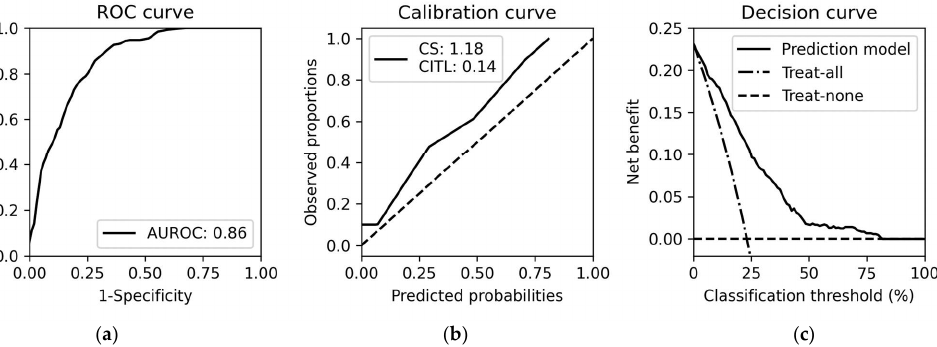
Figure 2. ARC predictor performance represented by ( a ) ROC curve; ( b ) calibration curve ( c ) decision curve. AUROC, area under the receiver operating characteristics curve; CS, calibration slope; CITL, calibration-in-the-large.